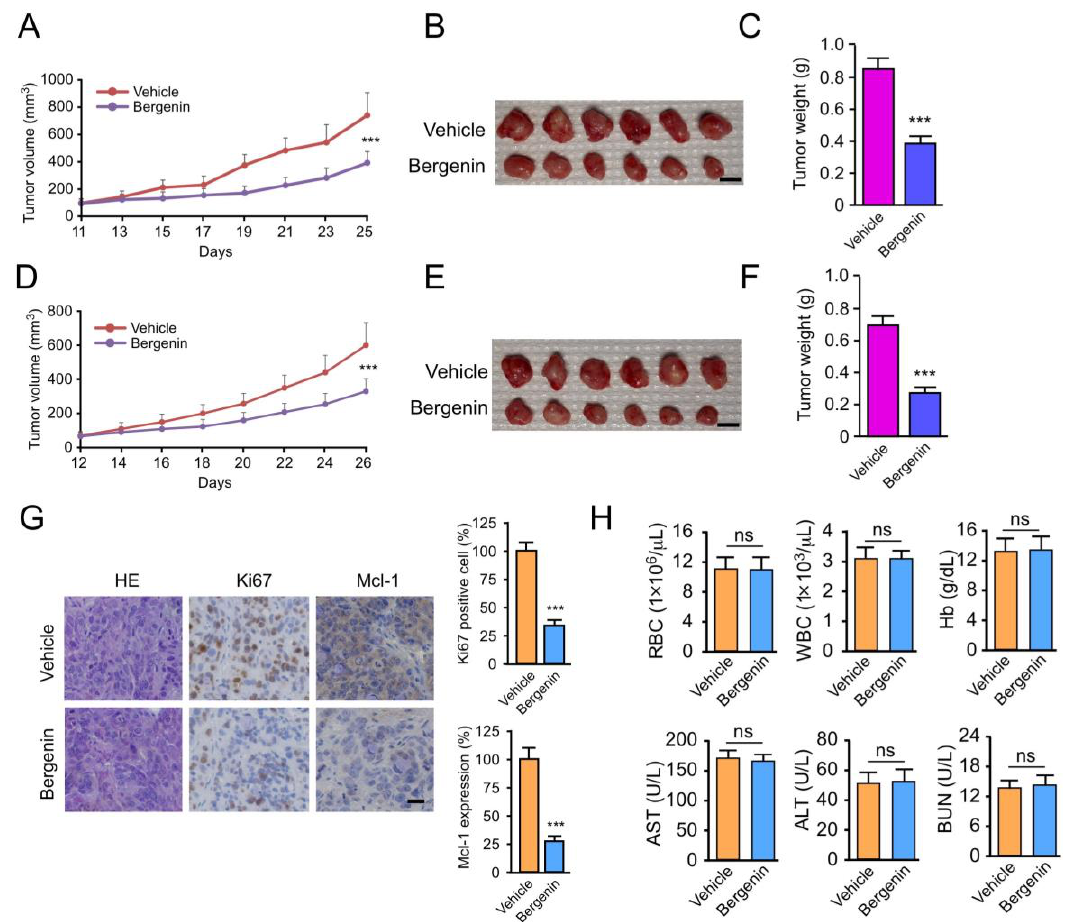
Figure 6. Bergenin inhibits tumor growth in vivo, *** p < 0.001. ( A – C ) HCT116-derived xenograft tumors were treated with vehicle control or bergenin for different time periods, and subsequently tumor volume ( A ), mass image ( B ), and weight ( C ) were measured separately. Scale bar, 1 cm. Data are represented as mean ± SD (n = 3). ( D – F ) Treatment of HT29-derived xenograft tumors with vehicle control or bergenin, followed by measurement of tumor volume ( D ), mass image ( E ), and weight ( F ). Scale bar, 1 cm. Data are represented as mean ± SD (n = 3). ( G ) HCT116-derived xenograft tumors were treated with vehicle control or bergenin, followed by IHC staining and assays for Ki67 and Mcl-1 expression. Scale bar, 25 µ m. Data are represented as mean ± SD (n = 6); 2 tissue slides per tumor. ( H ) Blood specimens were analyzed for white blood cells (WBC), red blood cells (RBC), hemoglobin (Hb), alanine aminotransferase (ALT), aspartate aminotransferase (AST), and blood urea nitrogen (BUN) with/without bergenin treatment. Data are represented as mean ± SD (n = 3).